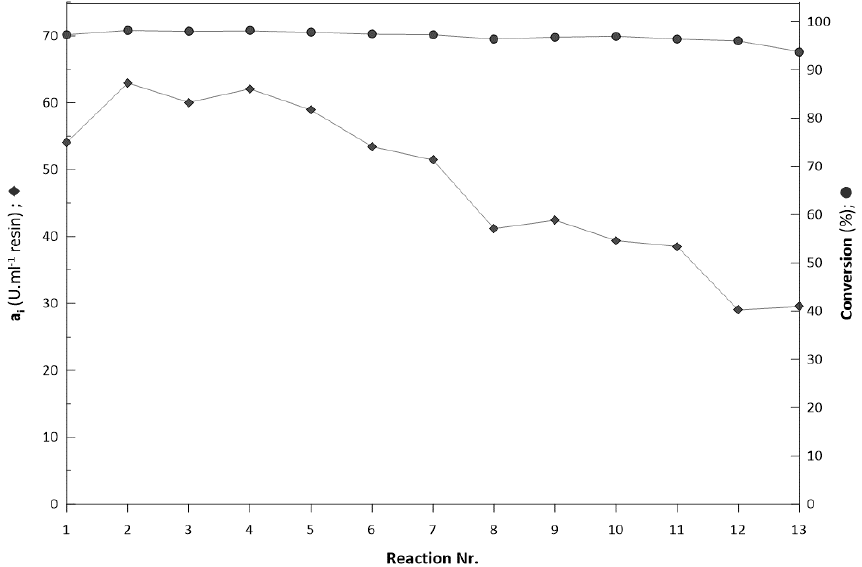
Figure 11. Repeated biotransformation with substrate concentration of 190 mM.